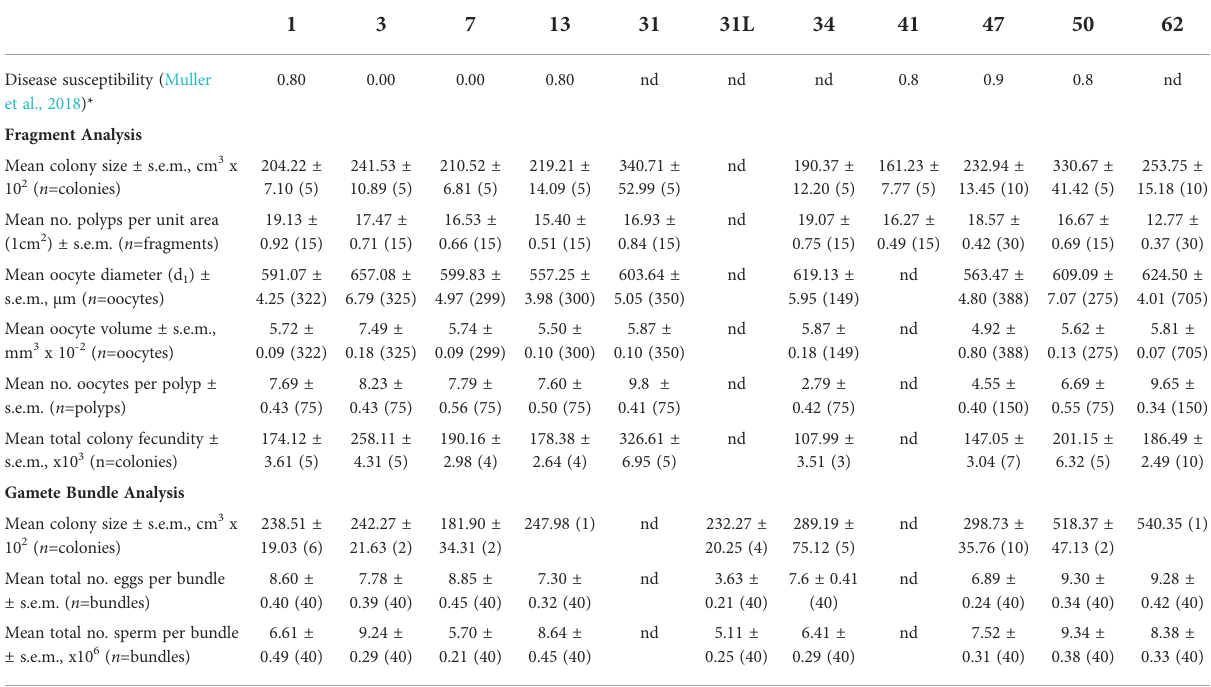
TABLE 1 Mean values for all